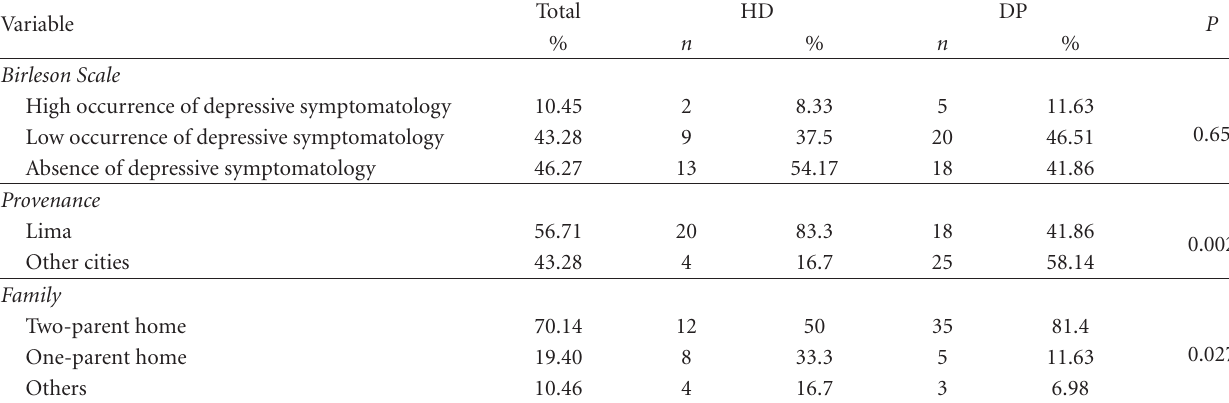
Table 3: Features according to dialysis types.